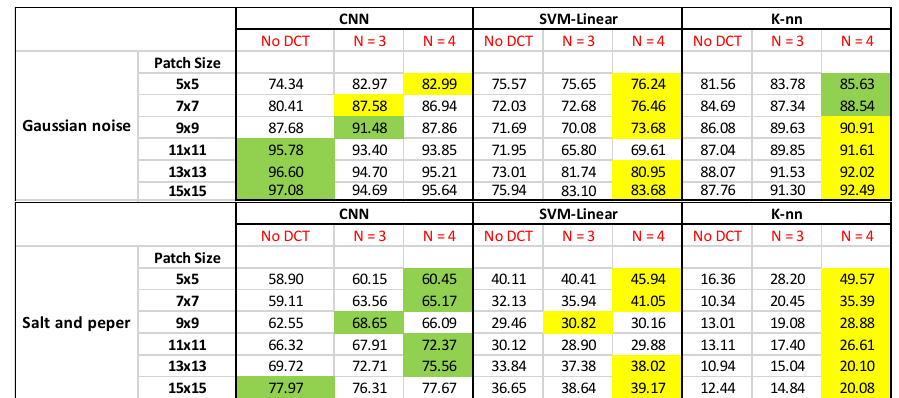
Figure 6: Salinas Dataset: Classification accuracy rates for CNN, SVM and k-NN based approaches, for Gaussian and Salt & Pepper noise, for different patch sizes and different numbers of zeroed high-frequency DCT coefficients. Yellow-coloured rates show the best performing configuration per technique, and green- coloured rates the best performing one among all techniques for the given patch size.